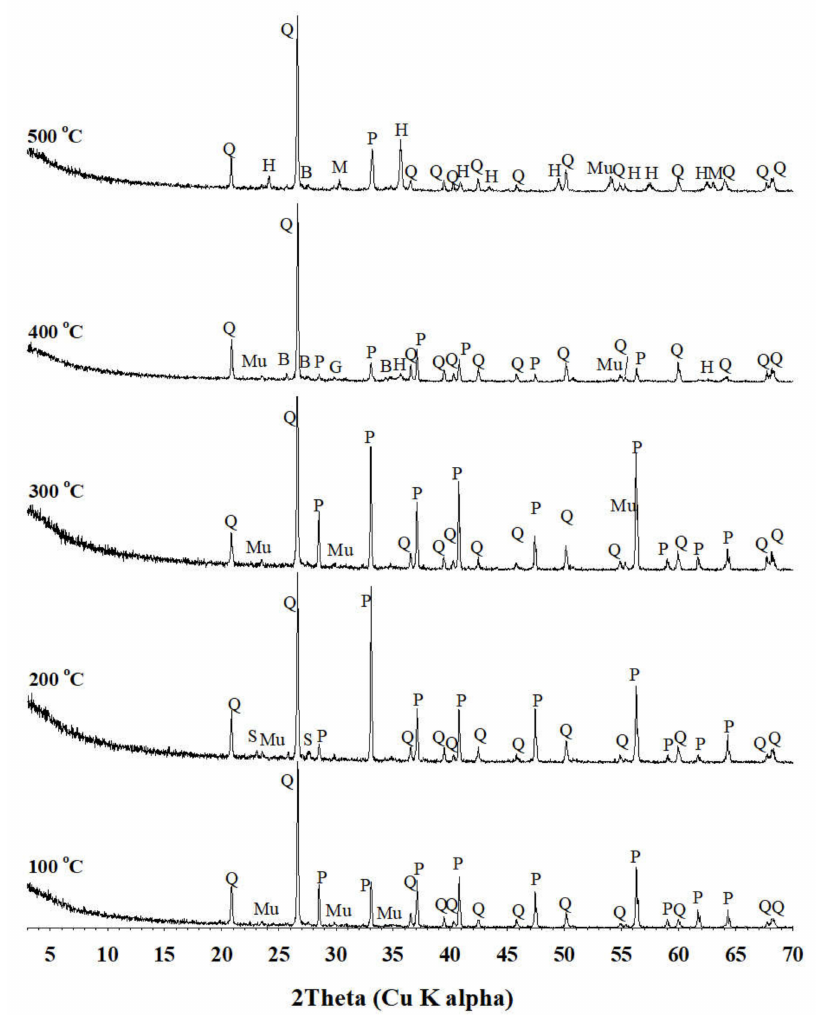
Figure 8. XRD patterns of the solid residue after hot water leaching. B, bassanite; G, galena; H, hematite; M, magnetite; Mu, muscovite; P, pyrite; Q, quartz; and S,